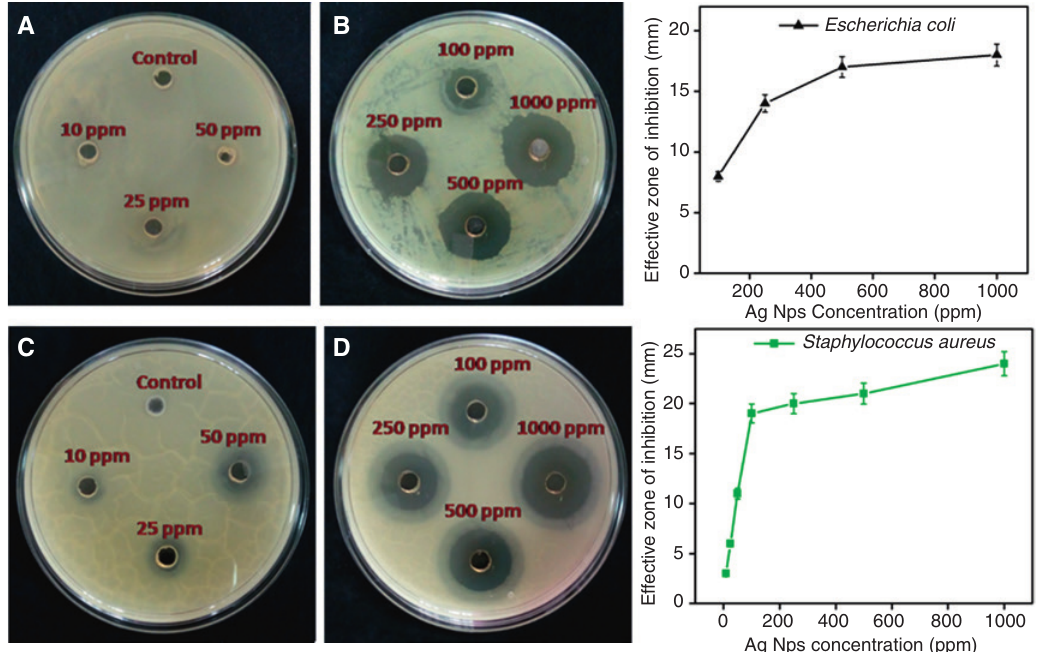
Figure 6: Antimicrobial activity of Escherichia coli (A), (B) and Staphylococcus aureus (C) and (D) as a function of different